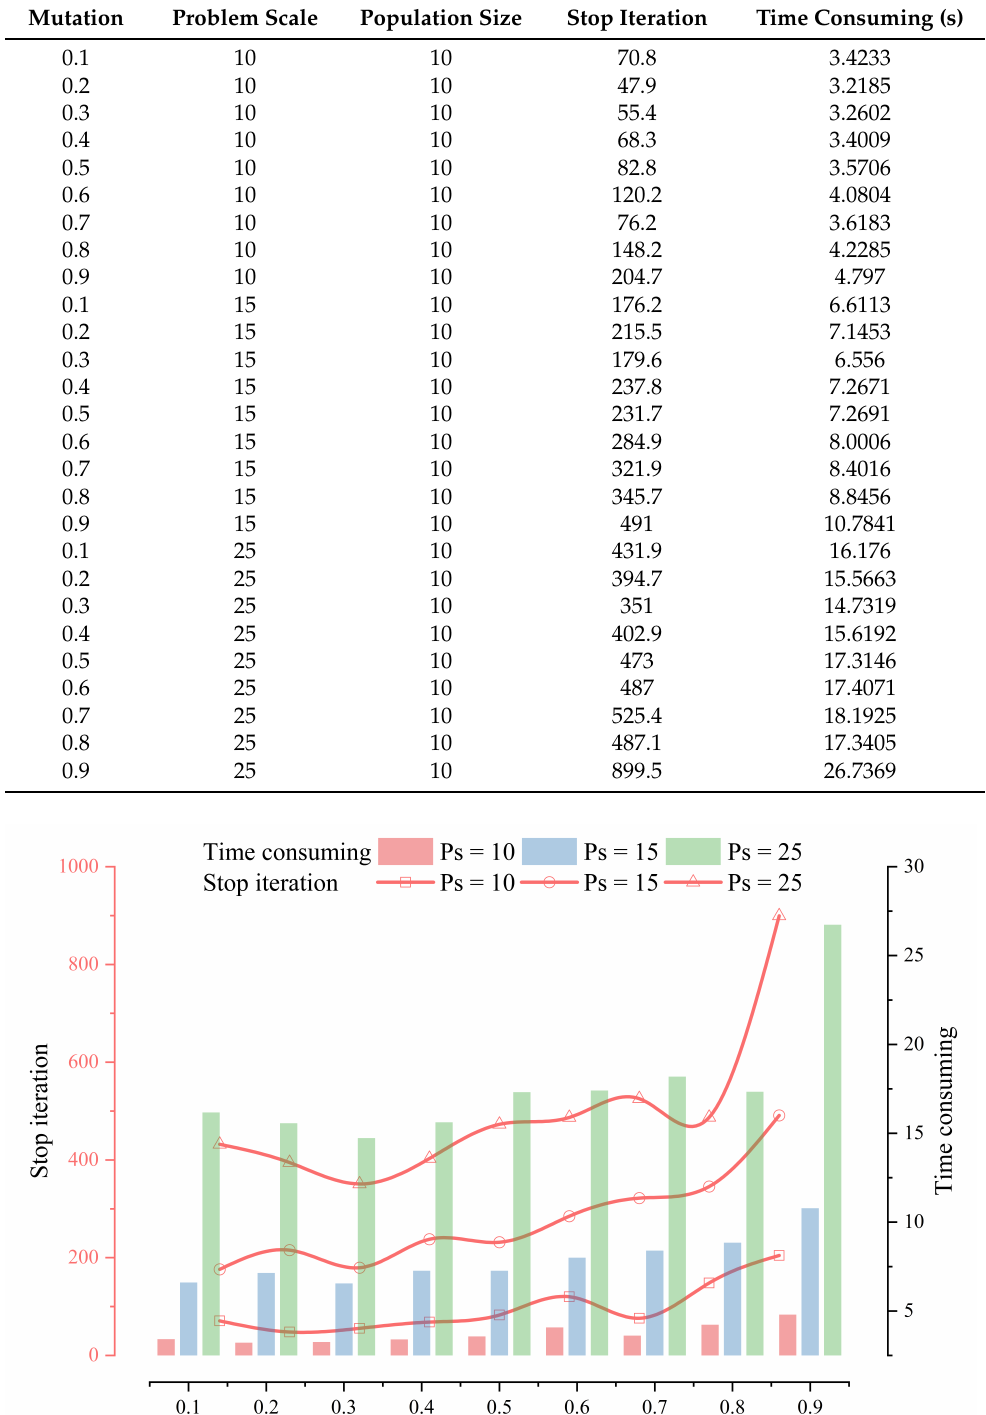
Table 9. Mutation parameter sensitivity analysis results.